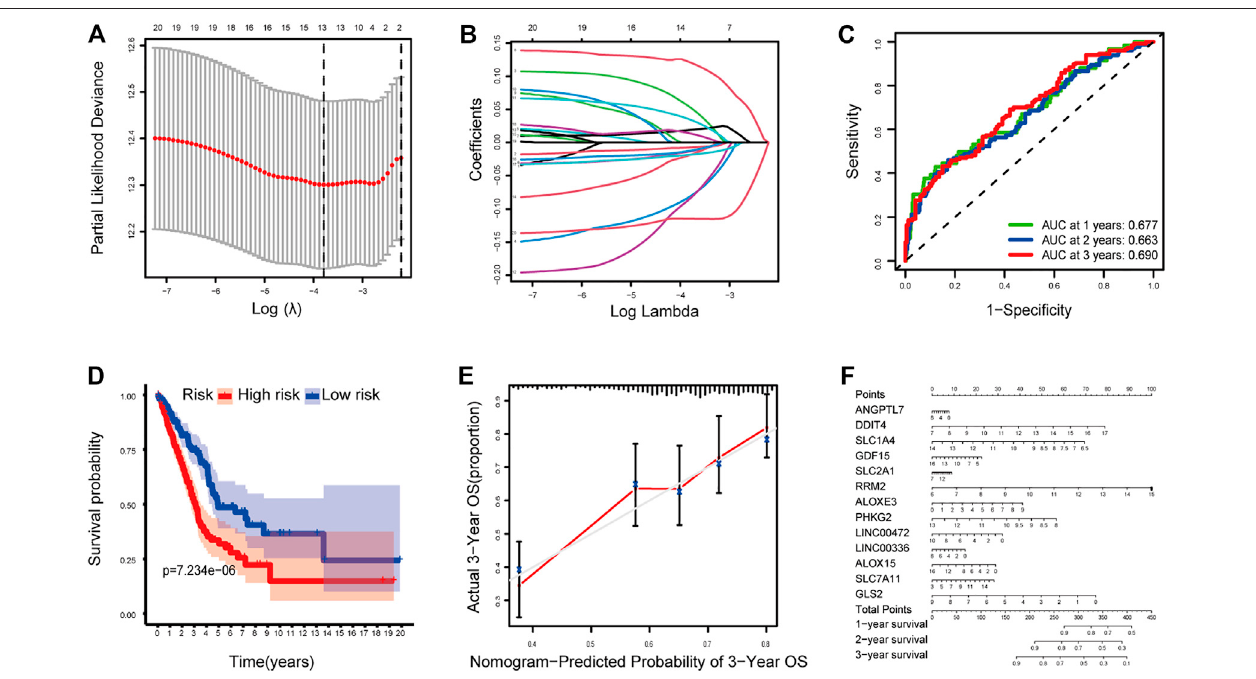
FIGURE 2 | (A – B) Model diagnosis process Lasso regression curves which were constructed by the Ferroptosis-related genes signature. (C) AUC of timedependent ROC curves veri fi ed the predicting prognostic performance. (D) Kaplan – Meier curves for the OS of patients in the high-risk group and low-risk group. (E-F) The calibration curves and nomogram. ROC, receiver operating characteristic curve. * p <